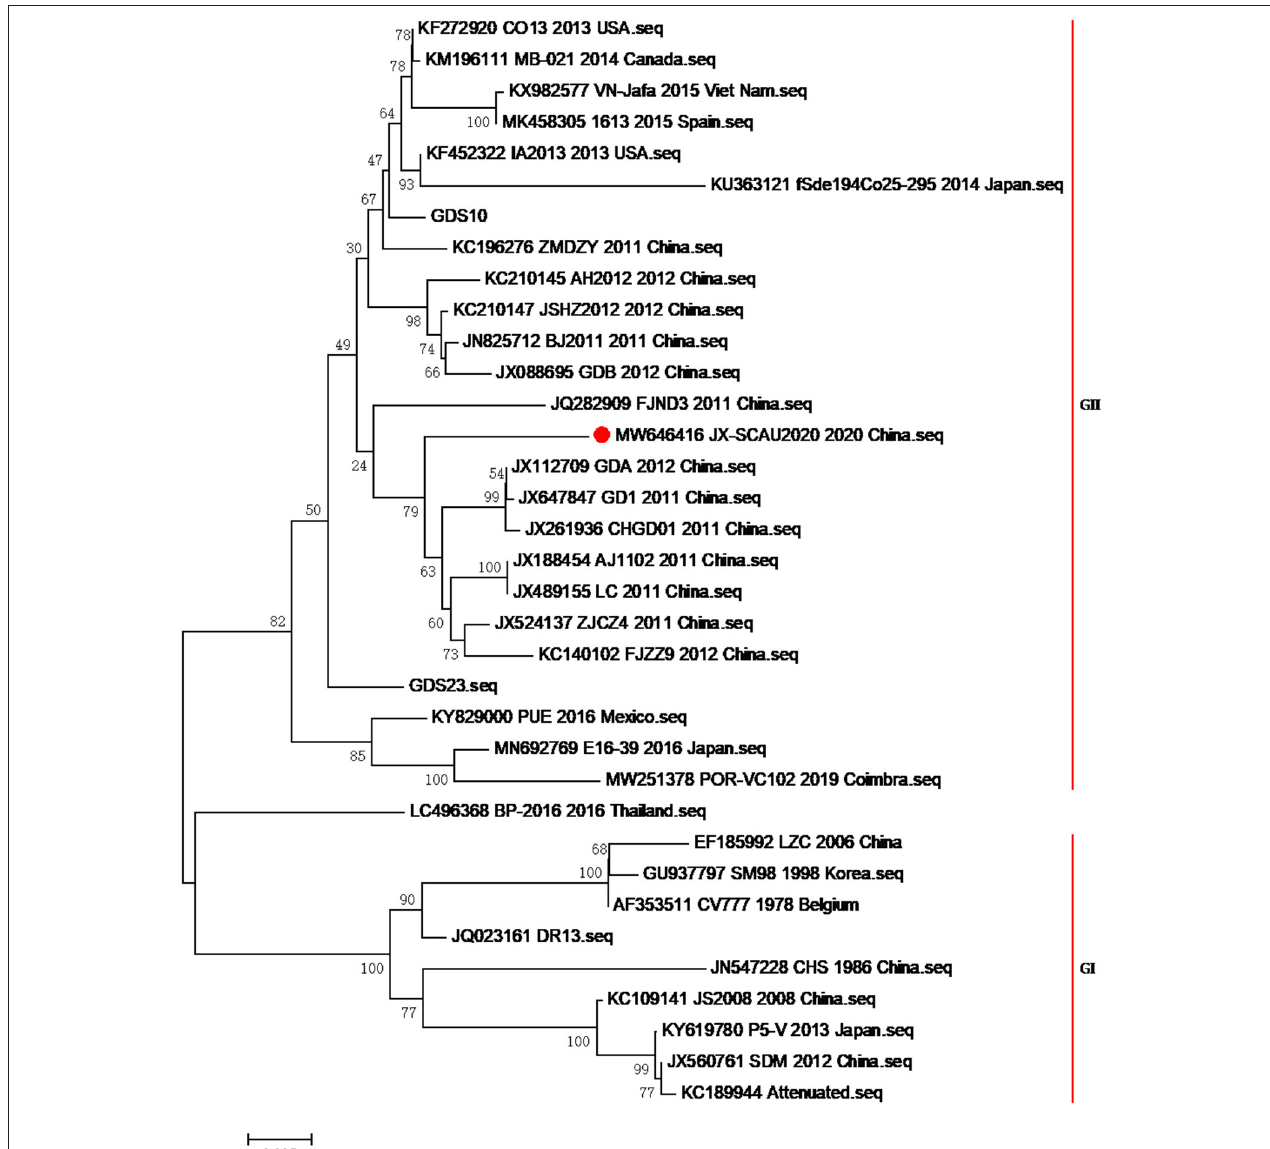
FIGURE 2 | Phylogenetic trees of isolates and a representative virus based on the S gene sequence. The tree was performed by neighbor-joining method using MEGA with 1,000 bootstrap replicates. The GenBank accession numbers, strains, years, and places of isolation are shown on the right in order, and the genogroups of the virus are shown on the right of strains.